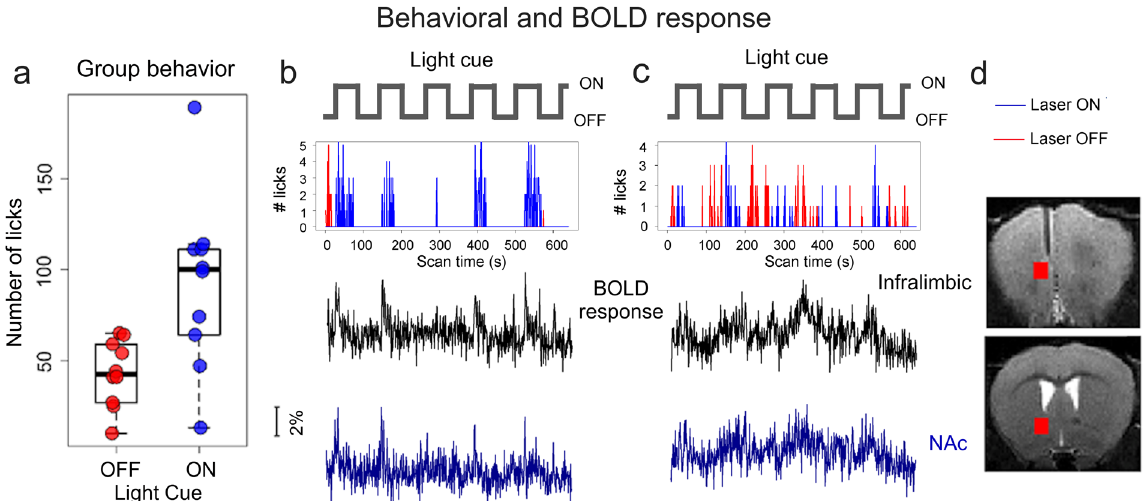
Fig. 2 Group behavior (spout licking) and raw time courses of behavioral and corresponding BOLD responses from two mice. a Counts of optogenetic stimulation self-administered by 10 mice averaged across the last 2 scan sessions. There was a signi fi cant increase in beam breaks during the cue ON versus OFF period ( p = 0.008, Wilcox Rank Sum test), suggesting that animals had learned the association between the cue and reward availability. b , c Raster plots of beam breaks from 2 mice during a 640 sec scan session with corresponding BOLD time courses in the infralimbic cortex (the stimulus loci) and the nucleus accumbens (NAc), indicated by the two red blocks in d . The blue and red lines in b and c indicate spout lick during cue ON and OFF respectively. Opto-ICSS was delivered only during cue